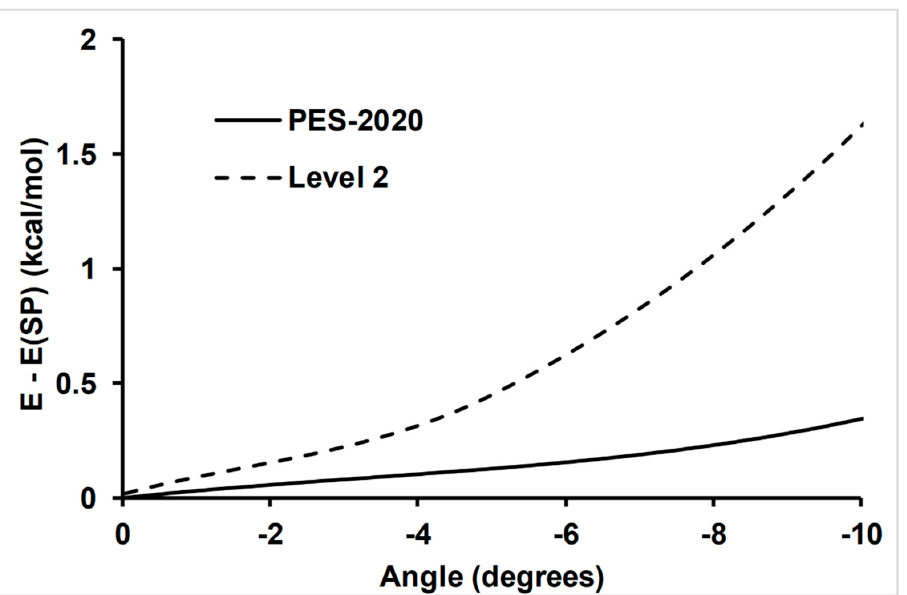
Figure 2. Dependence of energy on the bonding angle in the saddle point, N–H´–C. The equilibrium geometry at each calculation is taken as a reference (zero level). The other internal coordinates were fixed at the values in the respective saddle point. PES-2020, solid line; and Level 2, CCSD(T)/6-311++G(d,p), dashed line.